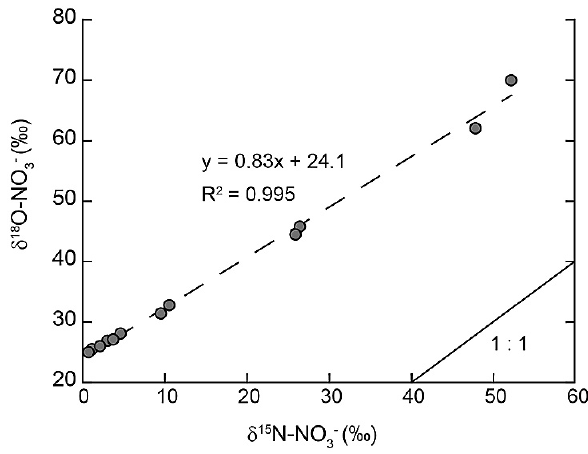
Fig. 5. Plot of δ 15 N NO 1:1 line is shown for